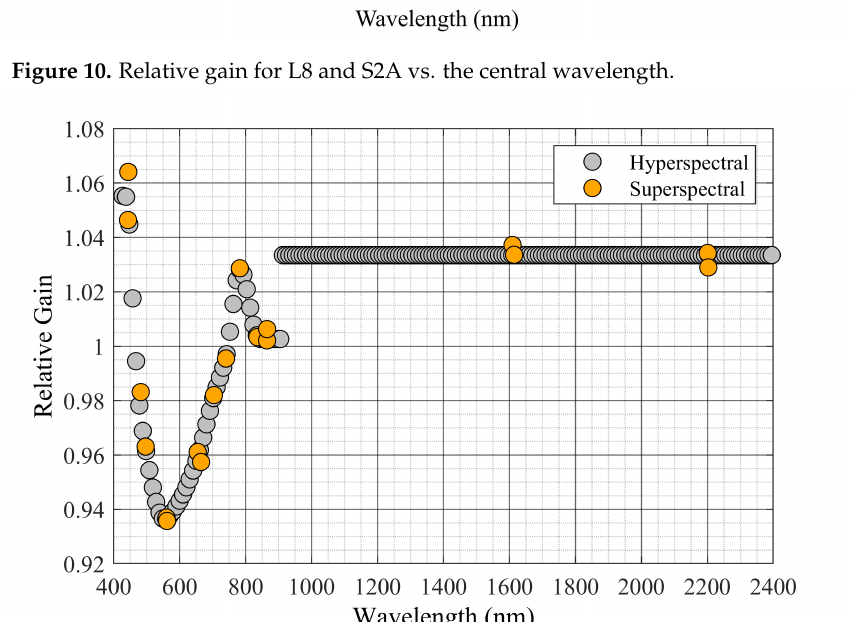
Figure 11. Superspectral and hyperspectral (for calibrated Hyperion wavelengths) relative